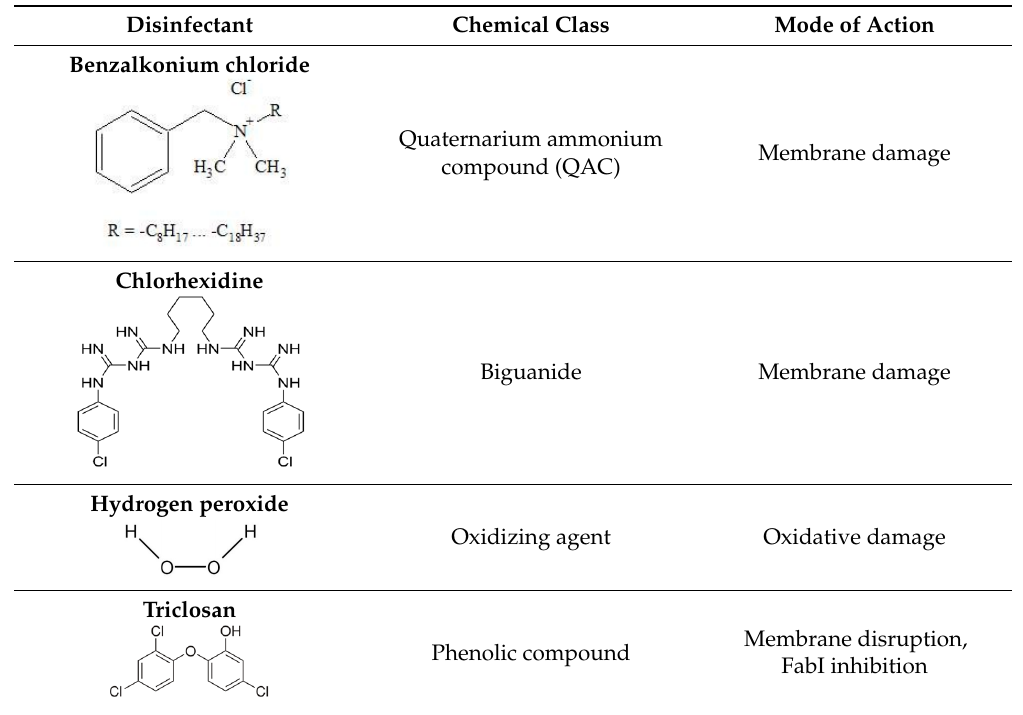
Table 1. Disinfectants chosen for this Table 1. Disinfectants chosen for this study. Table 1. Disinfectants chosen for this study. Table 1. Disinfectants chosen for this study. Table 1. Disinfectants chosen for this study.